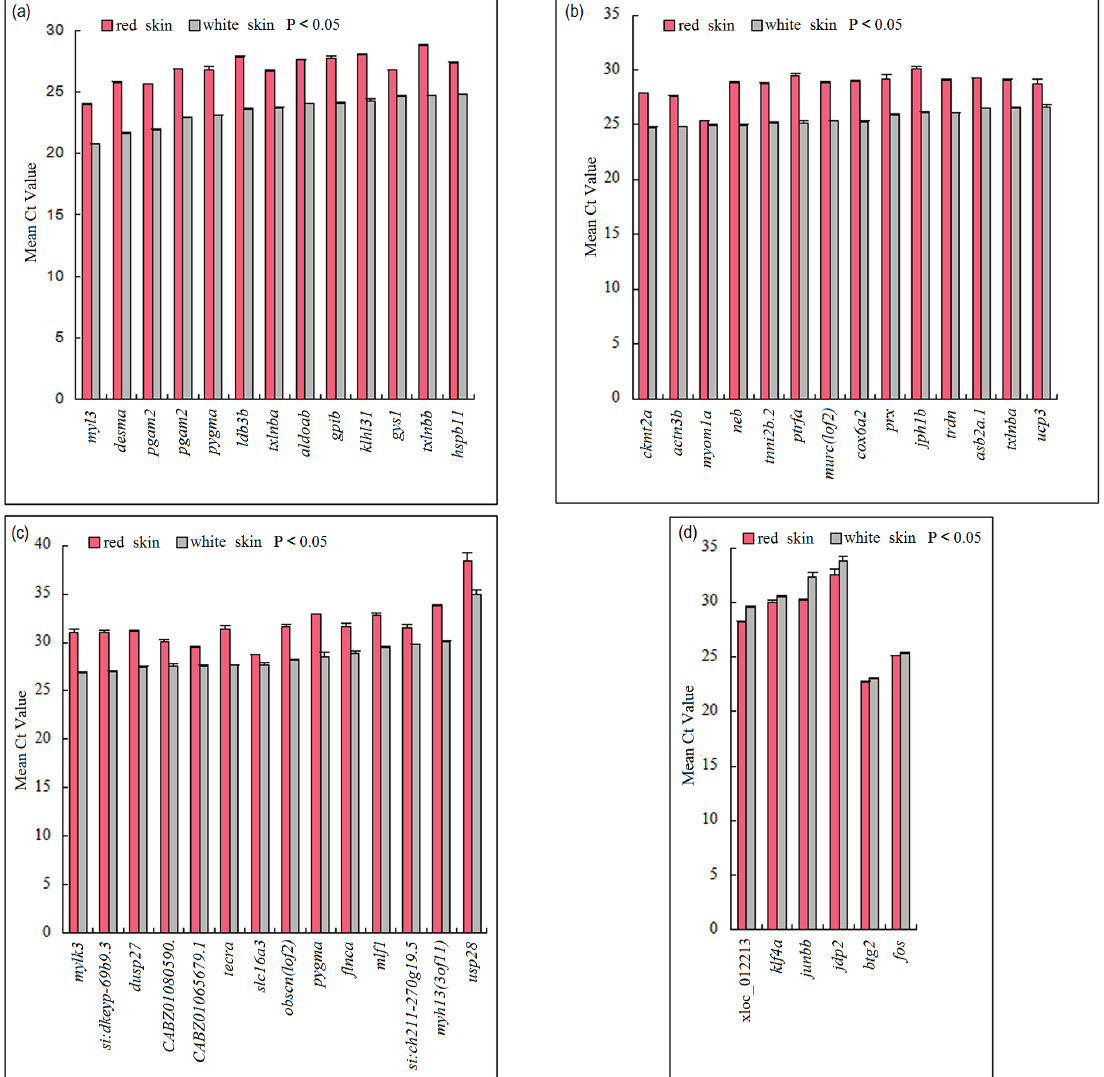
Figure 3. Significantly different normalized C t values of DEGs in red skin and white skin. The x -axis showed DEGs and the y -axis displayed the mean C t values. C t values analyzed with RT-qPCR were significantly different between red skin ( red ) and white skin ( grey ) (Student’s t -test p < 0.05). The genes in ( a – c ) were up-regulated in white skin and the genes in ( d ) were up-regulated in red